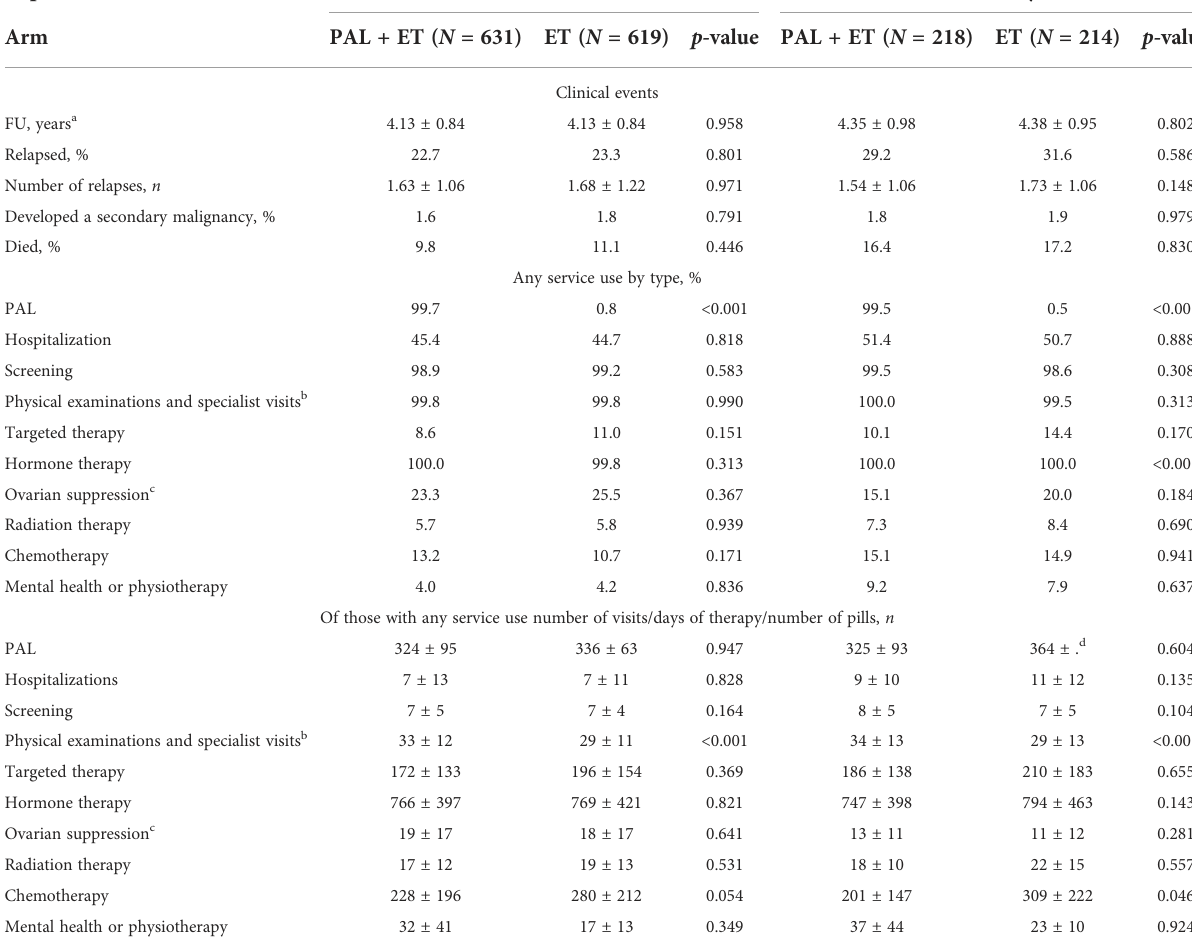
TABLE 1 Clinical events and